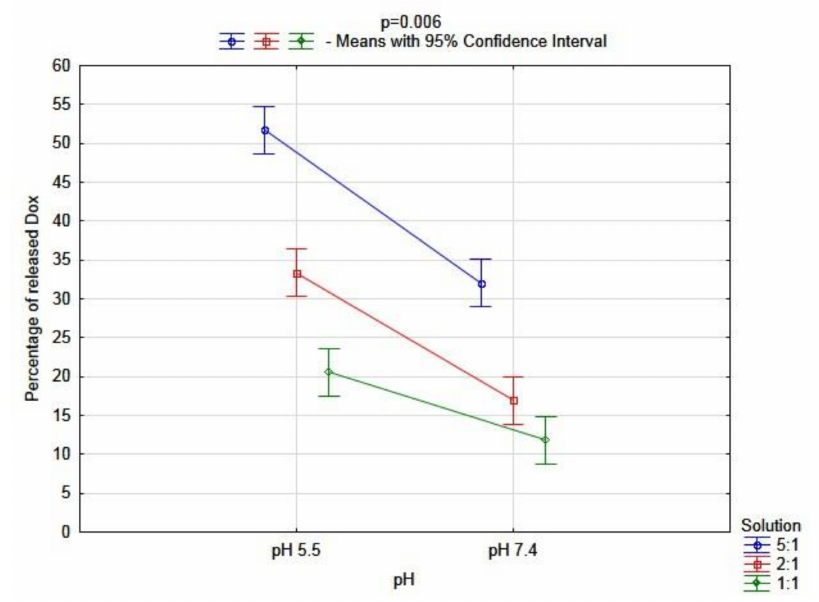
Figure 9. Multivariate analysis of the interaction between pH and molar ratio of BSA–CR–Dox on the percentage of the released Dox from the complex (n = 3 for each of S, in pH 5.5: S 5:1, Mean = 51.77 [95%CI: 48.72–54.82], S 2:1, Mean = 33.33 [95%CI: 30.29–36.38], S 1:1, Mean = 20.58 [95%CI: 17.54–23.63]; in pH 7.4: S 5:1, Mean = 32.06 [95%CI: 29.02–35.11], S 2:1, Mean = 16.94 [95%CI: 13.89–19.98], S 1:1, Mean = 11.84 [95%CI: 8.80–14.89]; n—number of probes; S—solution; 95%CI—95% Confidence